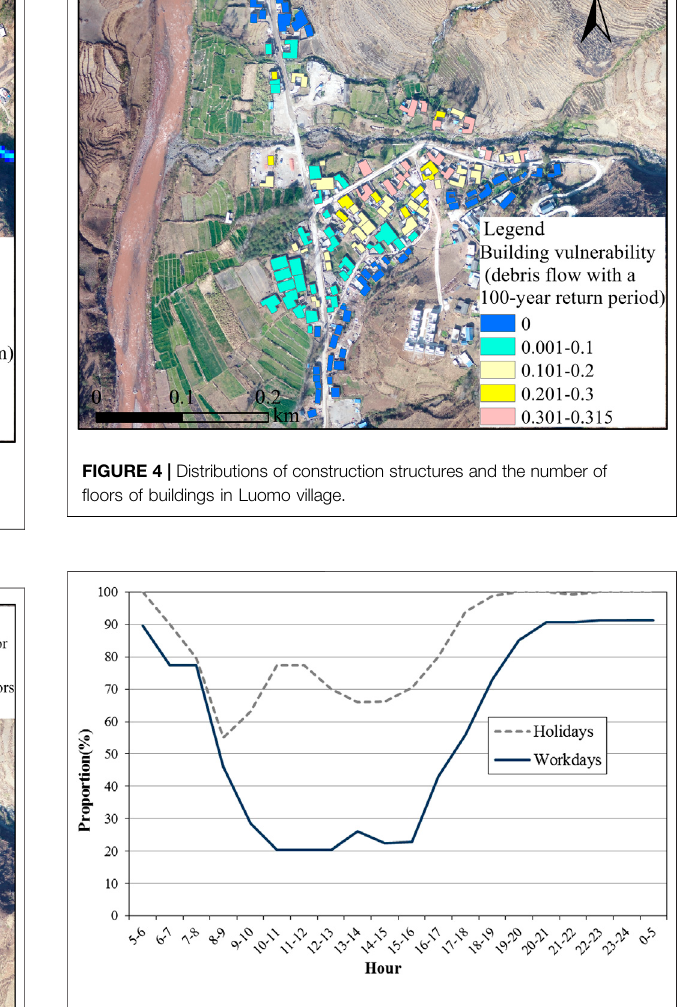
FIGURE 5 | Proportions of household members in buildings at different times on different